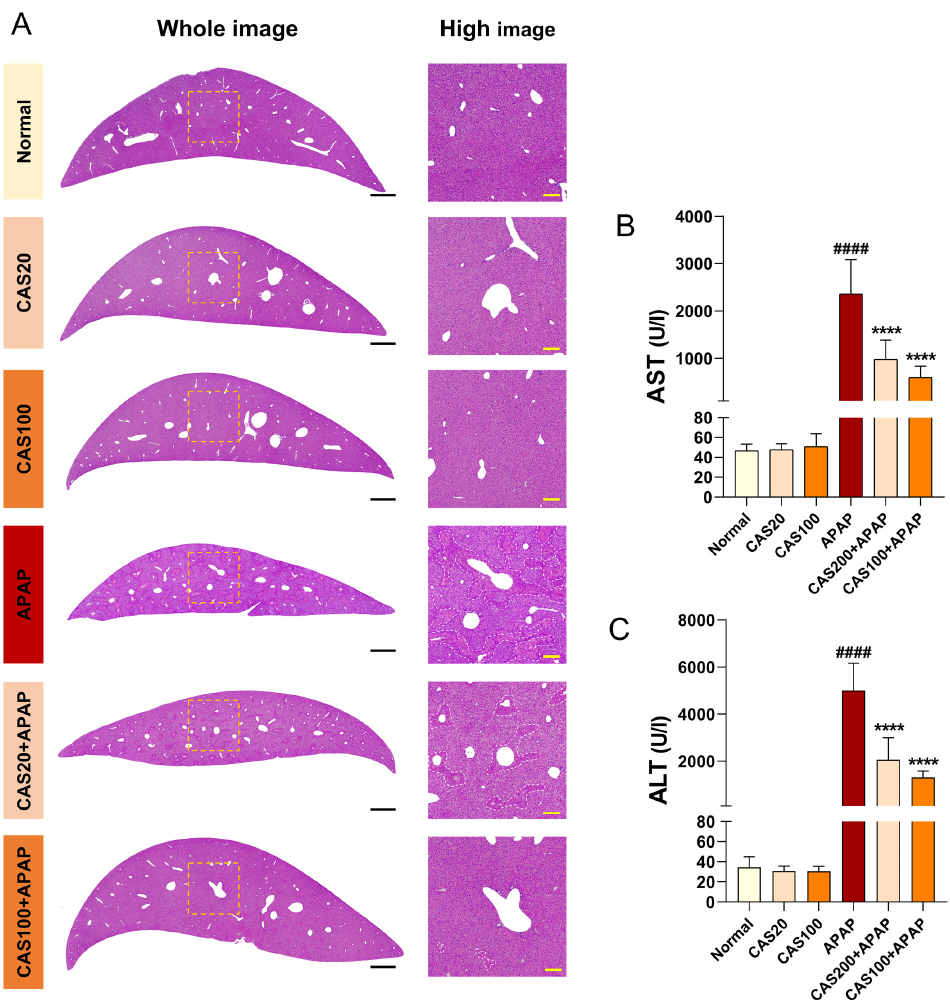
Figure 3. Prevention of histopathological liver damage by CAS administration in a mouse model of APAP-induced hepatotoxicity. ( A ) Representative H&E images of liver structural damage in the blank, control, and CAS groups. White scale bar = 1000 µ m, yellow scale bar = 100 µ m. ( B , C ) Quantitative analysis of the serum AST and ALT levels in blood from each group of mice ( n = 8). The data are expressed as the mean ± SEM and were analyzed via ordinary ANOVA with Tukey’s post-hoc analy- sis. Statistical differences are indicated as follows: #### p < 0.0001 vs. blank group; **** p < 0.0001 vs. APAP